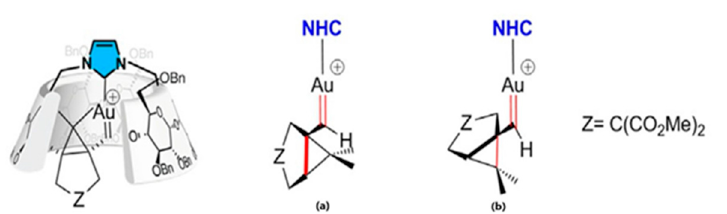
Figure 10. Stabilizing the conformation of a reactive intermediate, dependent on CD shape: ( a ) for α -CD and ( b ) for β -CD, determining the product distribution in a gold-catalyzed enyne cycloisomerization. Reprinted with permission from (Roland et al., 2018) [74]. Copyright 2018 Wiley.